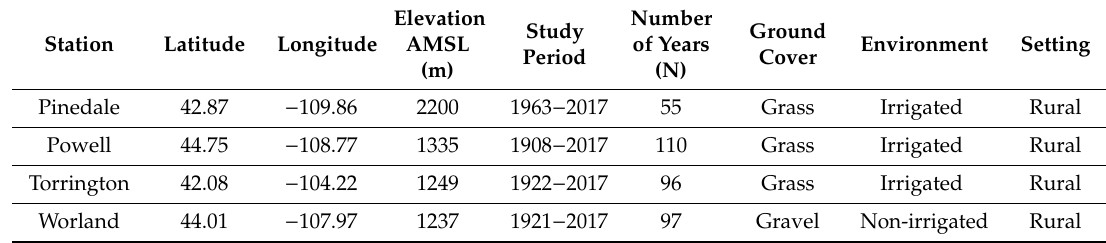
Table 1. Weather station metadata for select weather stations used in the